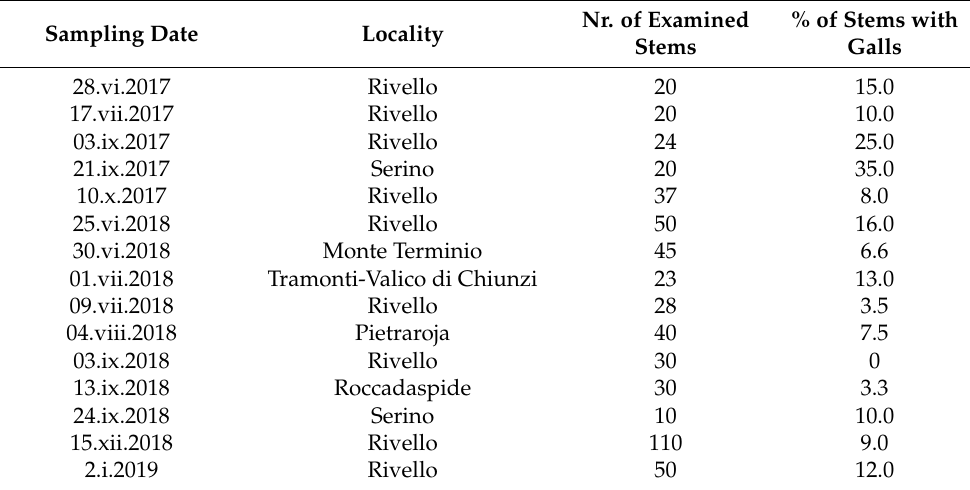
Table 2. Percentage of stems with flower galls on A. rivelloi